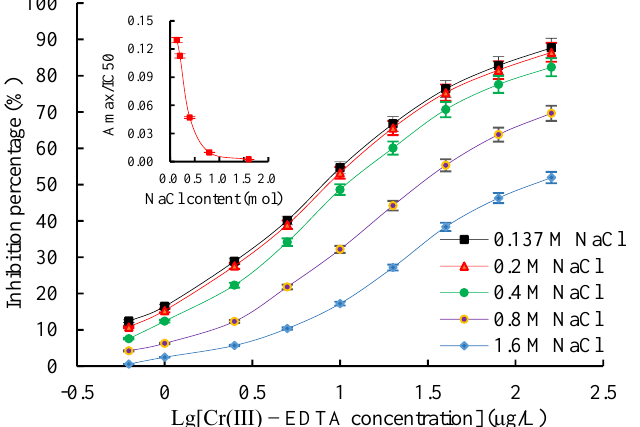
Figure 7. The effects of ionic strength on an icELISA. Insets indicate the fluctuations of Amax/IC50 as a function of ionic strength.